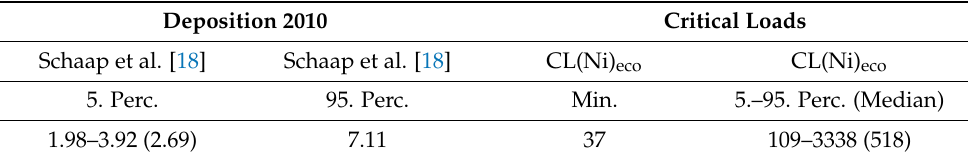
Table 13. Comparison of Ni deposition in 2010 (in g ha − 1 a − 1 ) with the critical loads (in g ha − 1 a − 1 ) of receptor areas in Germany.